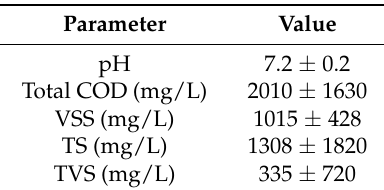
Table 1. Characteristics of anaerobic